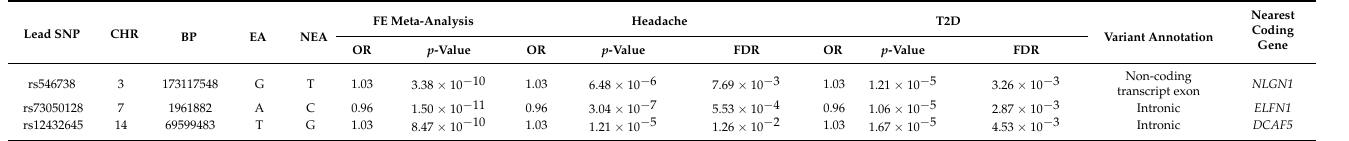
SNP: Single nucleotide polymorphism; CHR: Chromosome; BP: Base pair position (NCBI37/hg19); EA: Effect allele; NEA: Non-effect allele; OR: Odds ratio for EA; FE: Fixed effect; FDR: FDR-adjusted p value; T2D: Type 2 Diabetes, * These mapped genes are common with the genes found in cross-trait meta-analysis of headache and T2D. Table 4. Novel LD-independent ( r 2 < 0.1) lead SNPs from cross-trait meta-analysis of headache and T2D GWAS ( P meta < 5 × 10 − 8 ; single-trait FDR-adjusted p <